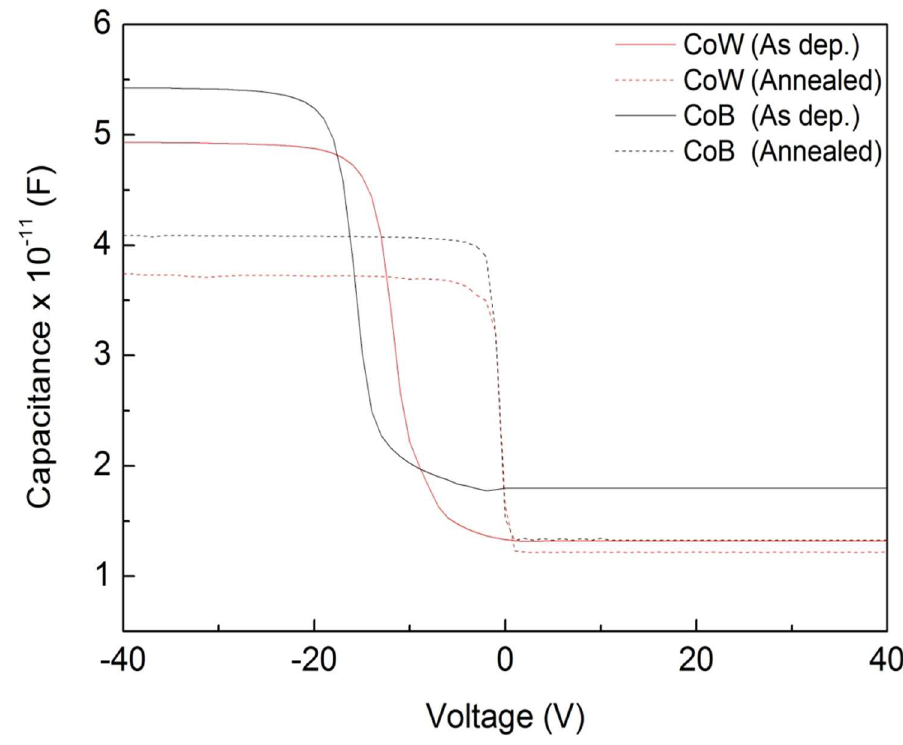
Figure 3. C-V curves of CoW-gate and CoB-gate MIS capacitors before and after annealing. Based on the measured C acc , the dielectric constant ( k ) of the SiO 2 film in the MIS capacitor can be determined by using k = C acc d / ε 0 A . Here, ε 0 is vacuum permittivity, d is film thickness, and A is the gate area. Figure 4 shows the k values of the SiO 2 film in the CoW-gate and CoB-gate MIS capacitors before and after 425 ◦ C annealing. The theoretical k value of the thermally grown SiO 2 film is 3.9~4.1. For the as-deposited CoW-gate and CoB- gate MIS capacitors, the k values of the SiO 2 films were determined to be 5.58 ± 0.32 and 6.07 ± 0.54, respectively. An increased k value demonstrates that the SiO 2 film was modified